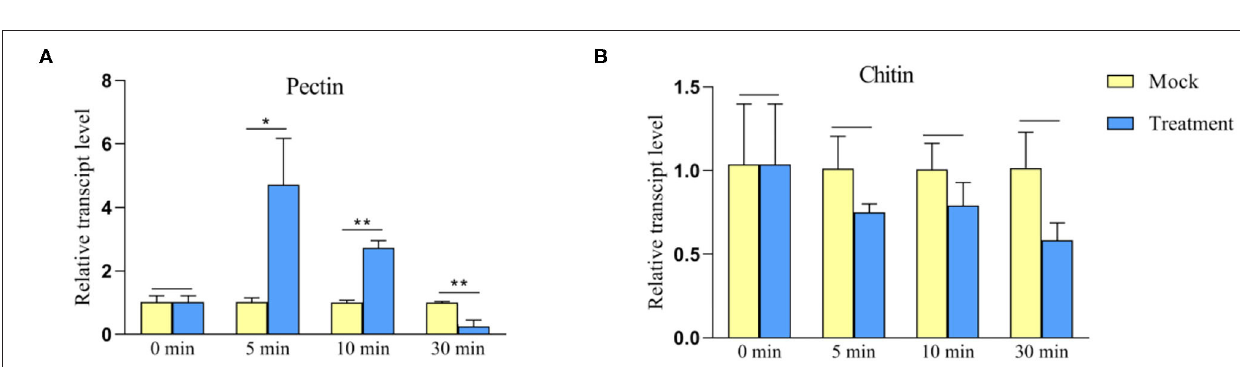
FIGURE 8 | Transcript profiles of TaWAK-6D in the wheat bottom leaves treated by either exogenous pectin or chitin. (A) Transcript profiles of TaWAK-6D in wheat cv. CI12633 leaves treated by 100 µ g/ml exogenous pectin. (B) Transcript profiles of TaWAK-6D in leaves of wheat cv. CI12633 after exogenous application of 100 µ g/ml chitin. The transcript level of TaWAK-6D in mock-treated wheat plants is set to 1. Statistically significant differences are analyzed based on three replications using a t -test (* P < 0.05, ** P < 0.01). Bars indicate the SEs of the